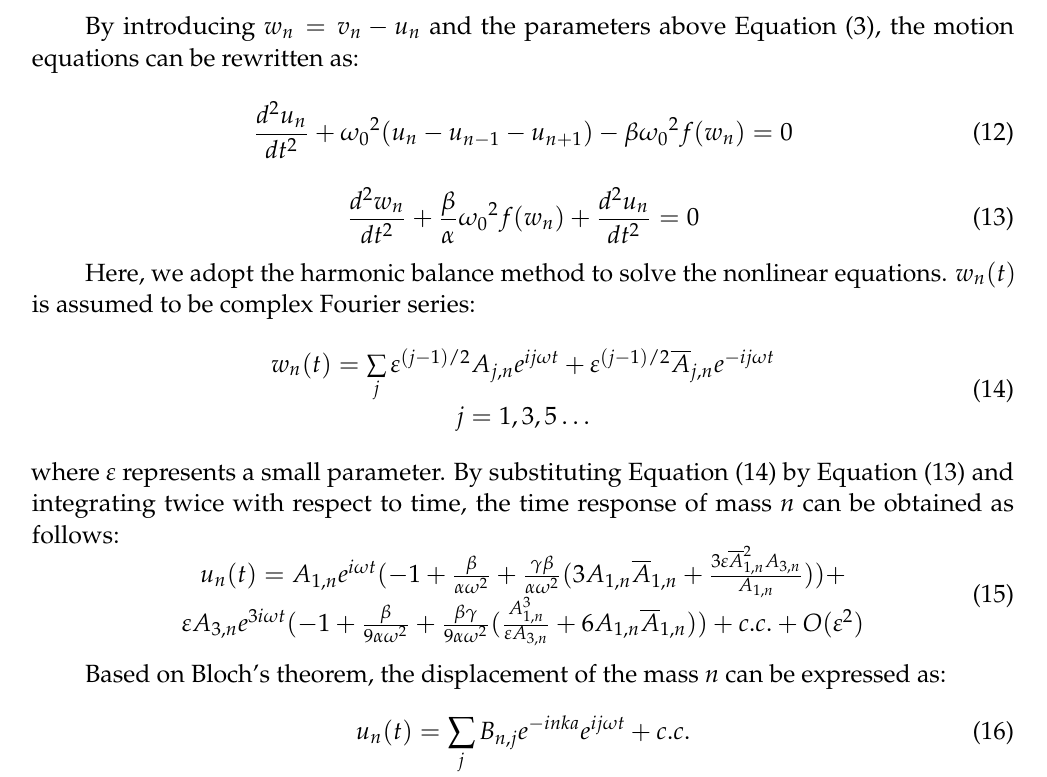
Figure 3. Nonlinear one-dimensional mass-spring lattices attached with local